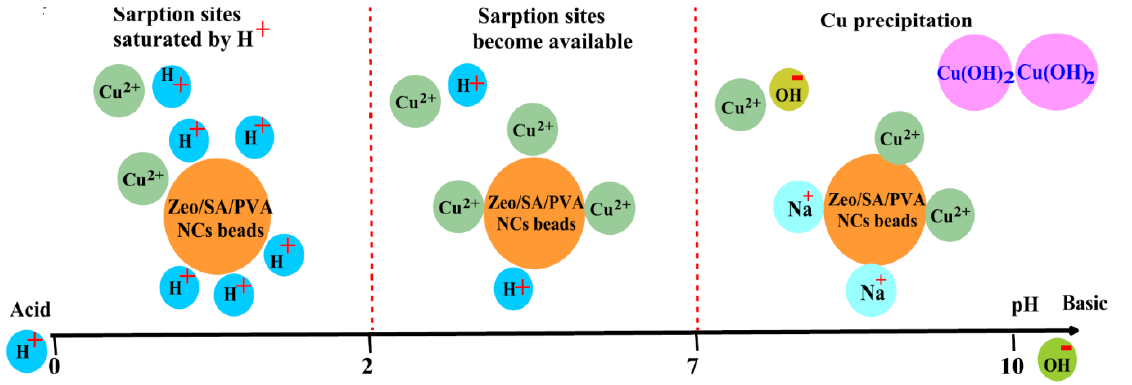
Figure 5. Effect of pH on the adsorption of heavy metals (ex.: Cu 2+ ) onto nano-Zeoilte polymeric (Reprint with permission from [76]).